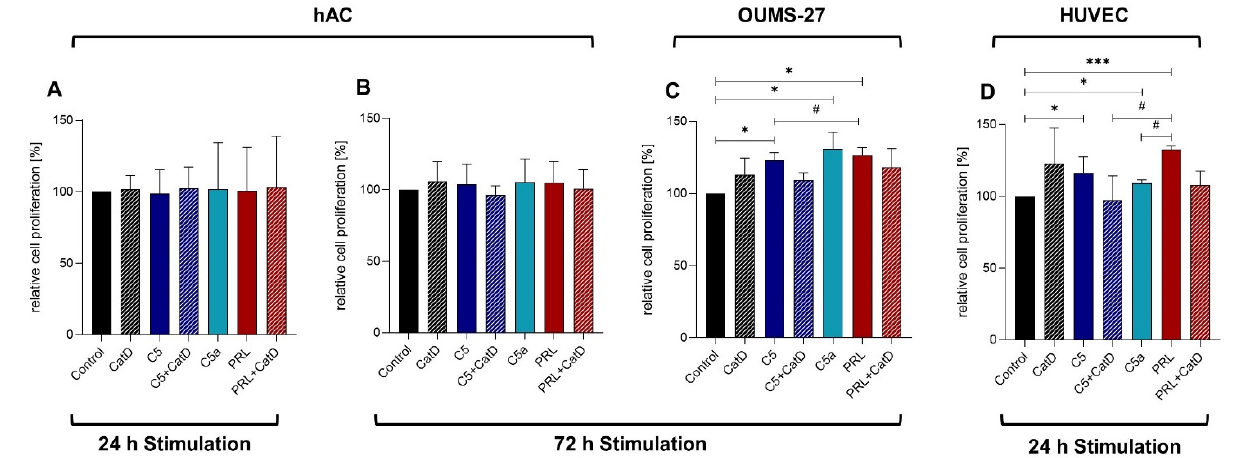
Figure 1. Graphic representation of the relative cell proliferation in response to 24 h ( A ) and 72 h ( B ) stimulation of human articular chondrocytes, 72 h stimulation of OUMS-27 ( C ), and 24 h stimulation of HUVEC ( D ) assessed by CyQUANT ® NF Cell Proliferation Assay. n = 3 ( A ), 5 ( B ), 3 ( C ), 5 ( D ) independent experiments with human articular chondrocytes from different donors. Mean with standard deviation. Control has been normalized to 100. One sample t -test with significance in relation to control (*). Mixed-effects analysis using post-hoc Tukey’s multiple comparisons (#). */# = p ≤ 0.05; *** = p ≤ 0.001.